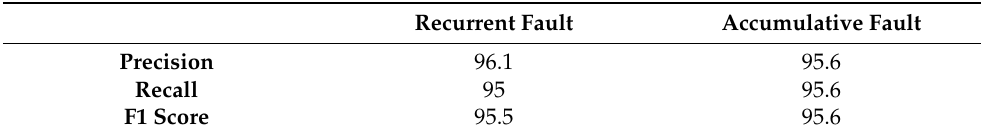
Figure 13. ML based Cloud management System.